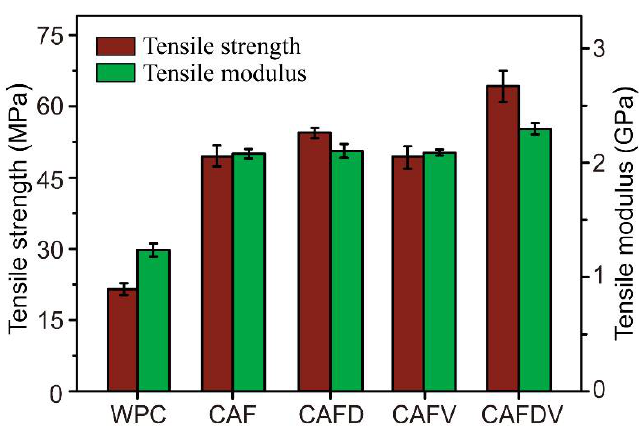
Figure 9. Tensile properties of the CAF reinforced WPCs.